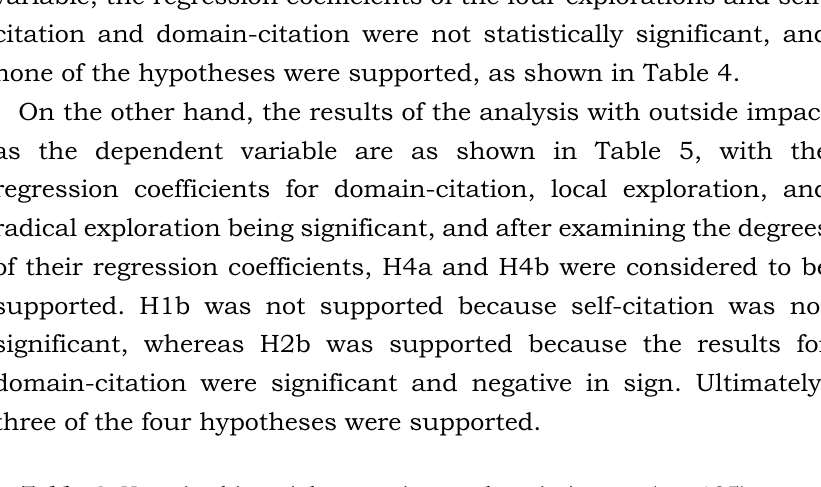
Table 4. Negative binomial regression on domain impact ( n =